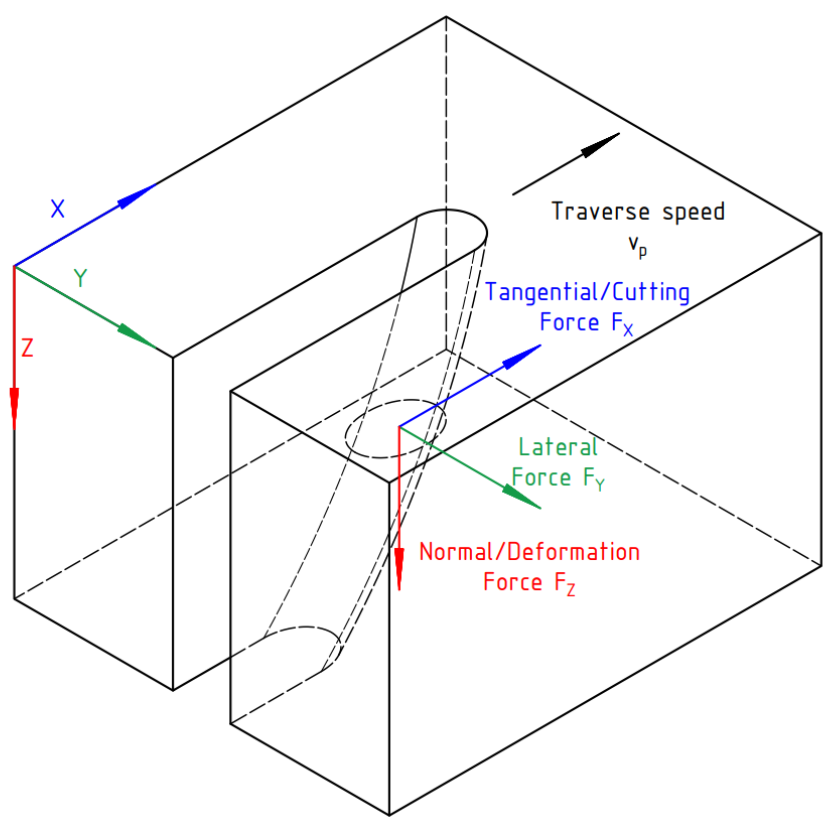
Figure 1. Direction of the exerted forces.